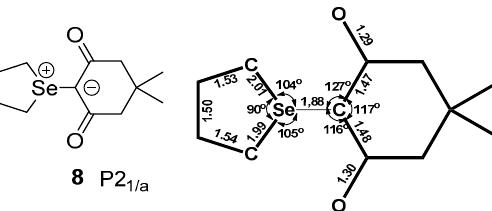
Figure 5. Selected cystallographic data of selenonium ylide 8 (taken from [23]).